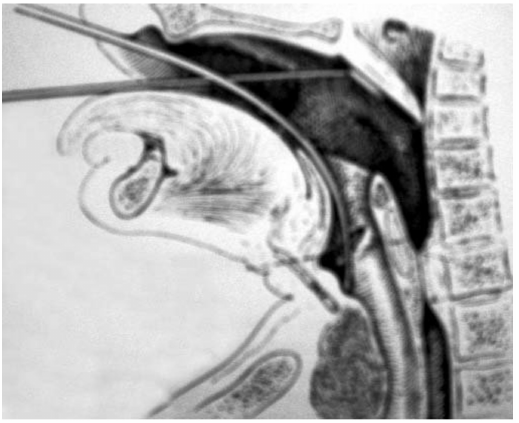
Figure 1. Killian laryngoscopy technique. This picture shows the technique of direct laryngoscopy developed by Killian.